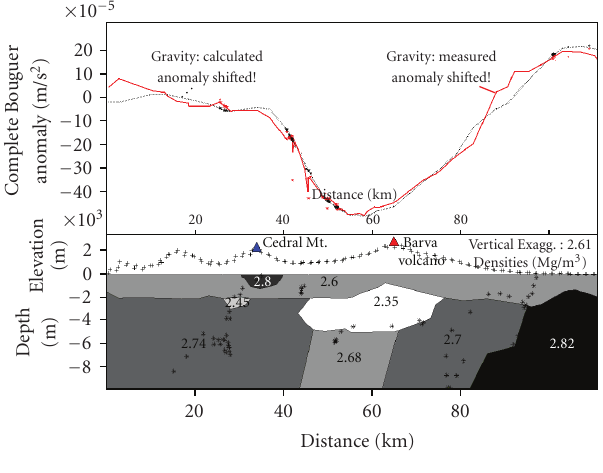
Figure 9: 3D density model cross section across the Barva volcano and surrounding regions. Red and black curves in the upper box show the measured and calculated gravity anomalies, respectively. Black plus-signs indicate topography derived from SRTM 3 arc sec grid which is projected on the cross section; black stars in the lower box show Euler source points. Grayscale polygons represent modeled crustal bodies with corresponding densities. Red triangle indicates the location of the main Quaternary volcanic vent; blue triangle indicates the location of the Cedral inferred paleo-volcanic